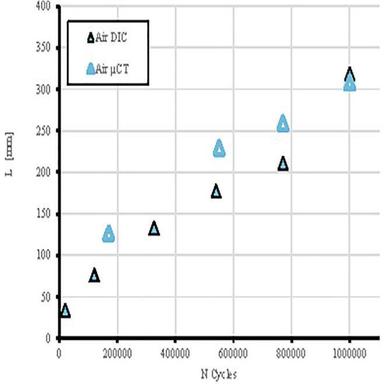
Quantitative comparison of crack length between DIC crack detection method and CT scan filtered segmentation during high temperature fatigue of woven composite specimen on Ply1 −45°.